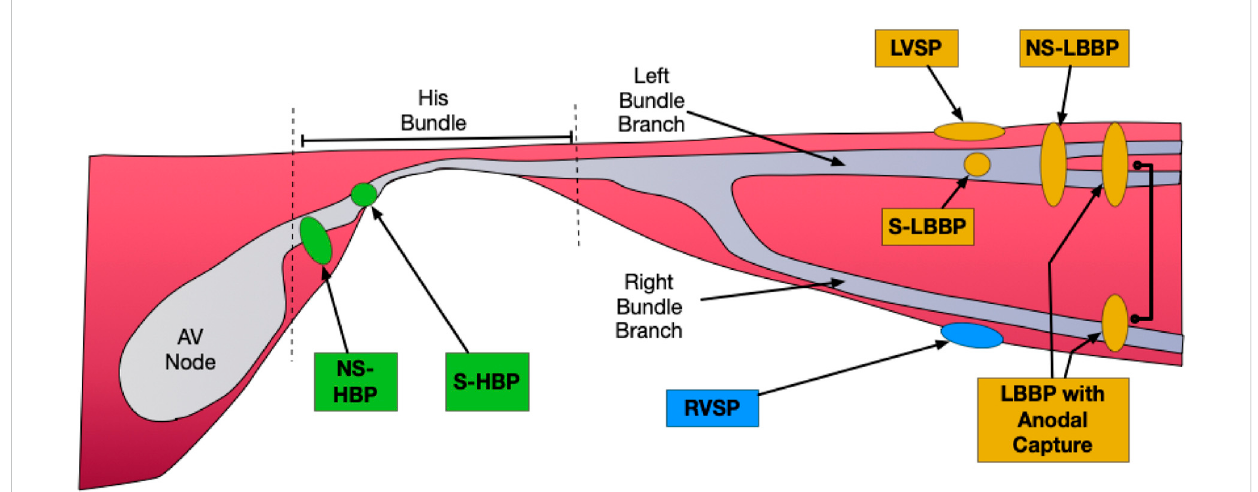
FIGURE 1 Forms of Conduction System Pacing. His Bundle Pacing (HBP) in green: Selective (without capture of local myocardium: S-HBP) and Non-Selective (with capture of local myocardium: NS-HBP). Forms of Left Bundle Branch Area Pacing (LBBAP) in orange: Selective (S-LBBP) and Non-Selective (NS- LBBP), and additionally LV Septal Pacing (LVSP- capture of the leftside of the septum without capture of the LBB), and LBBP with Anodal Capture (anodal ring electrode captures the RBB in addition to LBB capture by tip electrode). RV septal pacing (RVSP) in